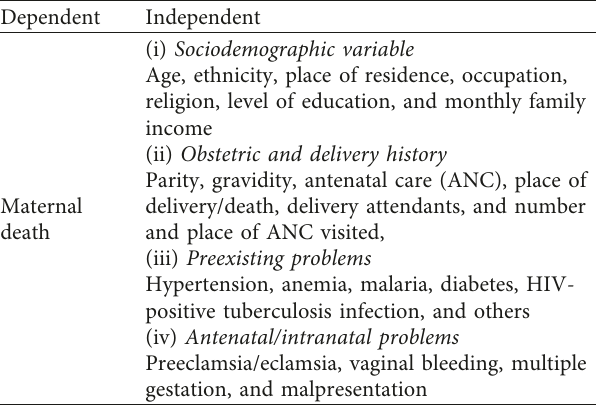
Table 1: List of the study